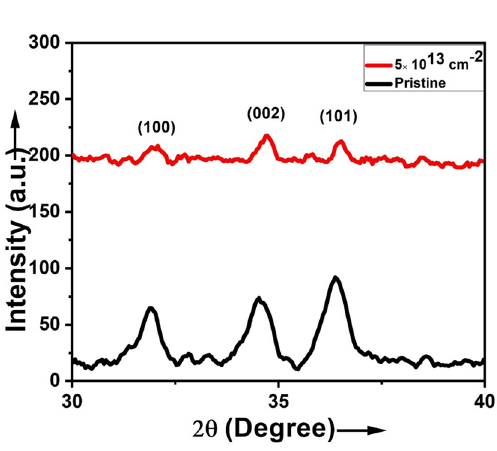
Figure 7. XRD patterns of pristine and 70 MeV Si 6+ ions beam irradiate 3at.% ZnO:Ga thin films.